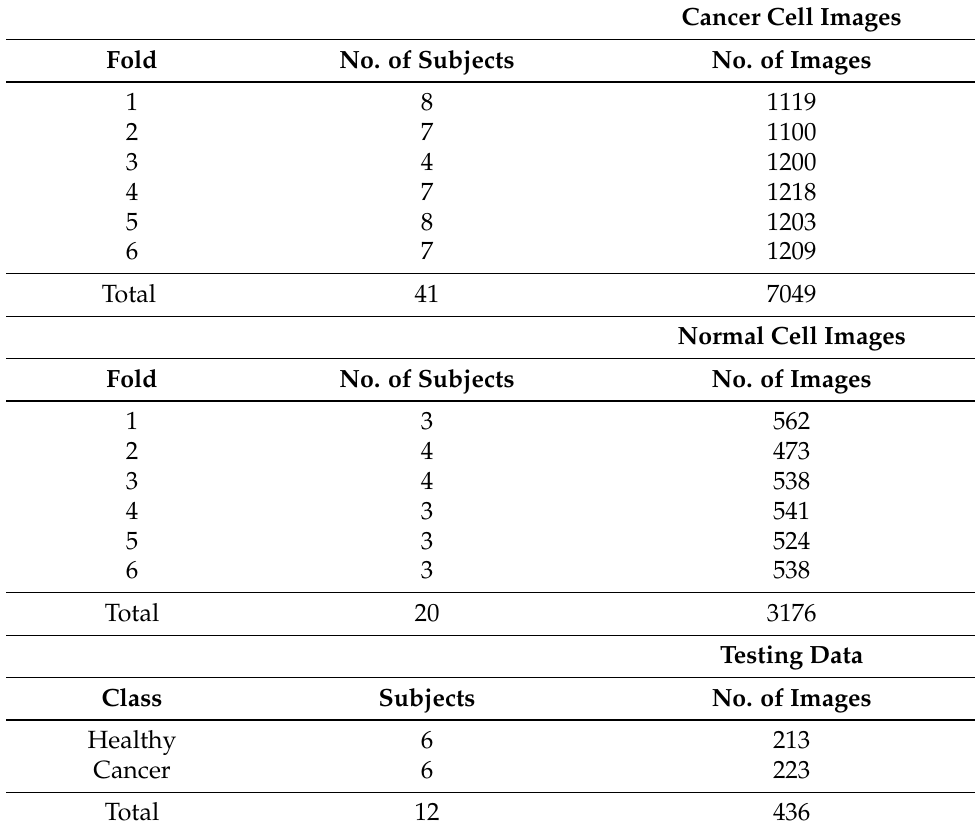
Table 1. The test and training data for each class is 7-fold. Folds 1–6 represents the training data. All cell images belonging to the same subject are placed in the same fold and not a single fold includes cell image from the same